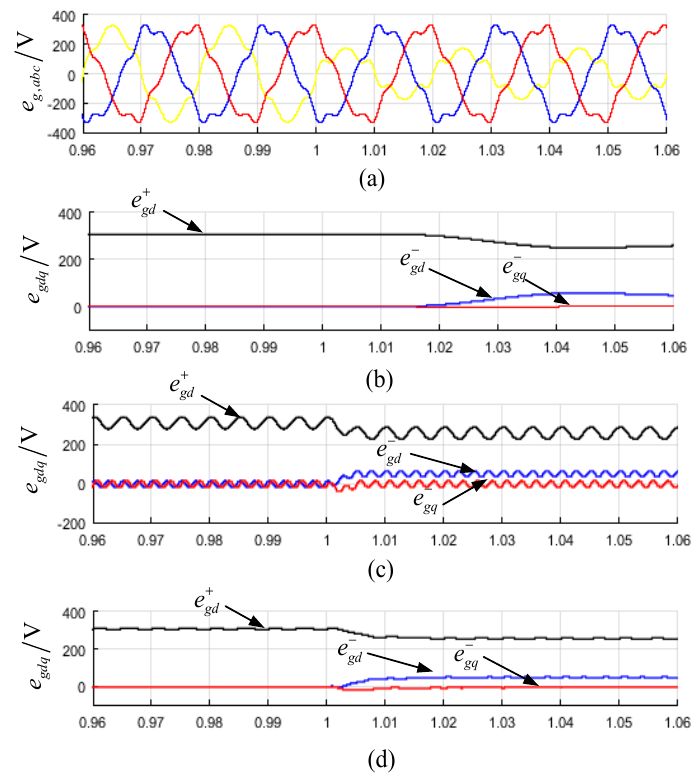
Figure 7. Positive- and negative-sequence components of the grid voltage dip of 50% using different methods. ( a ) Test voltage signals; ( b ) Low-Pass Filter (LPF); ( c ) Delayed Signal Cancellation (DSC); ( d ) DSOGI-FLL.